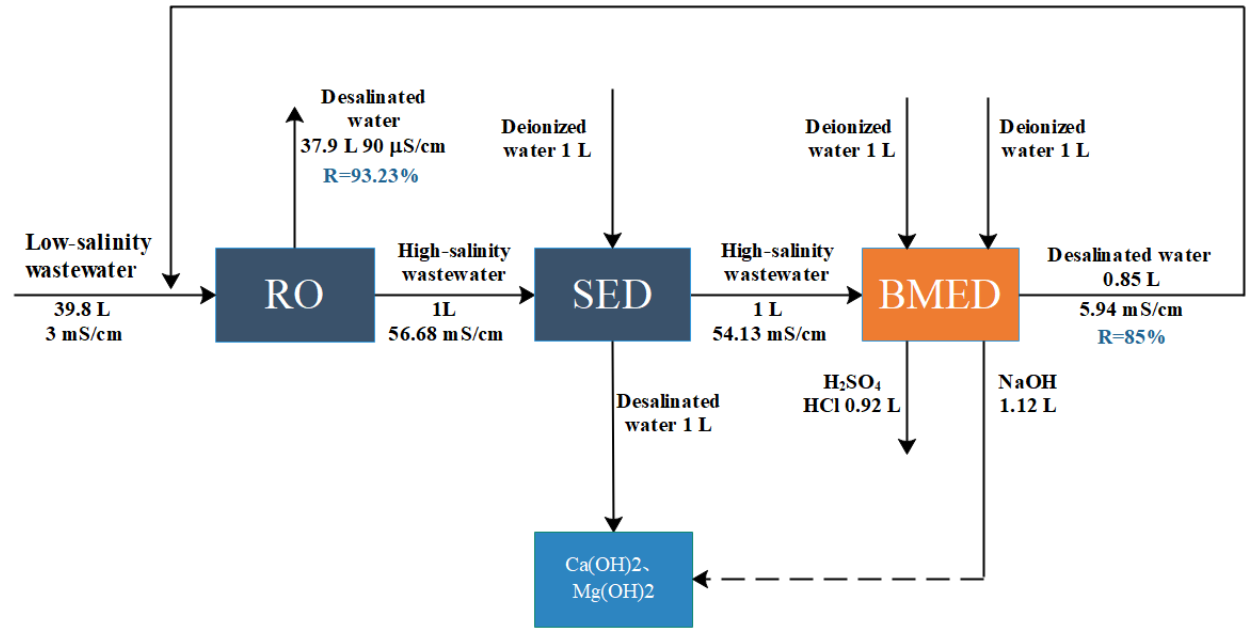
Figure 10. Schematic diagram of the water recovery for the entire